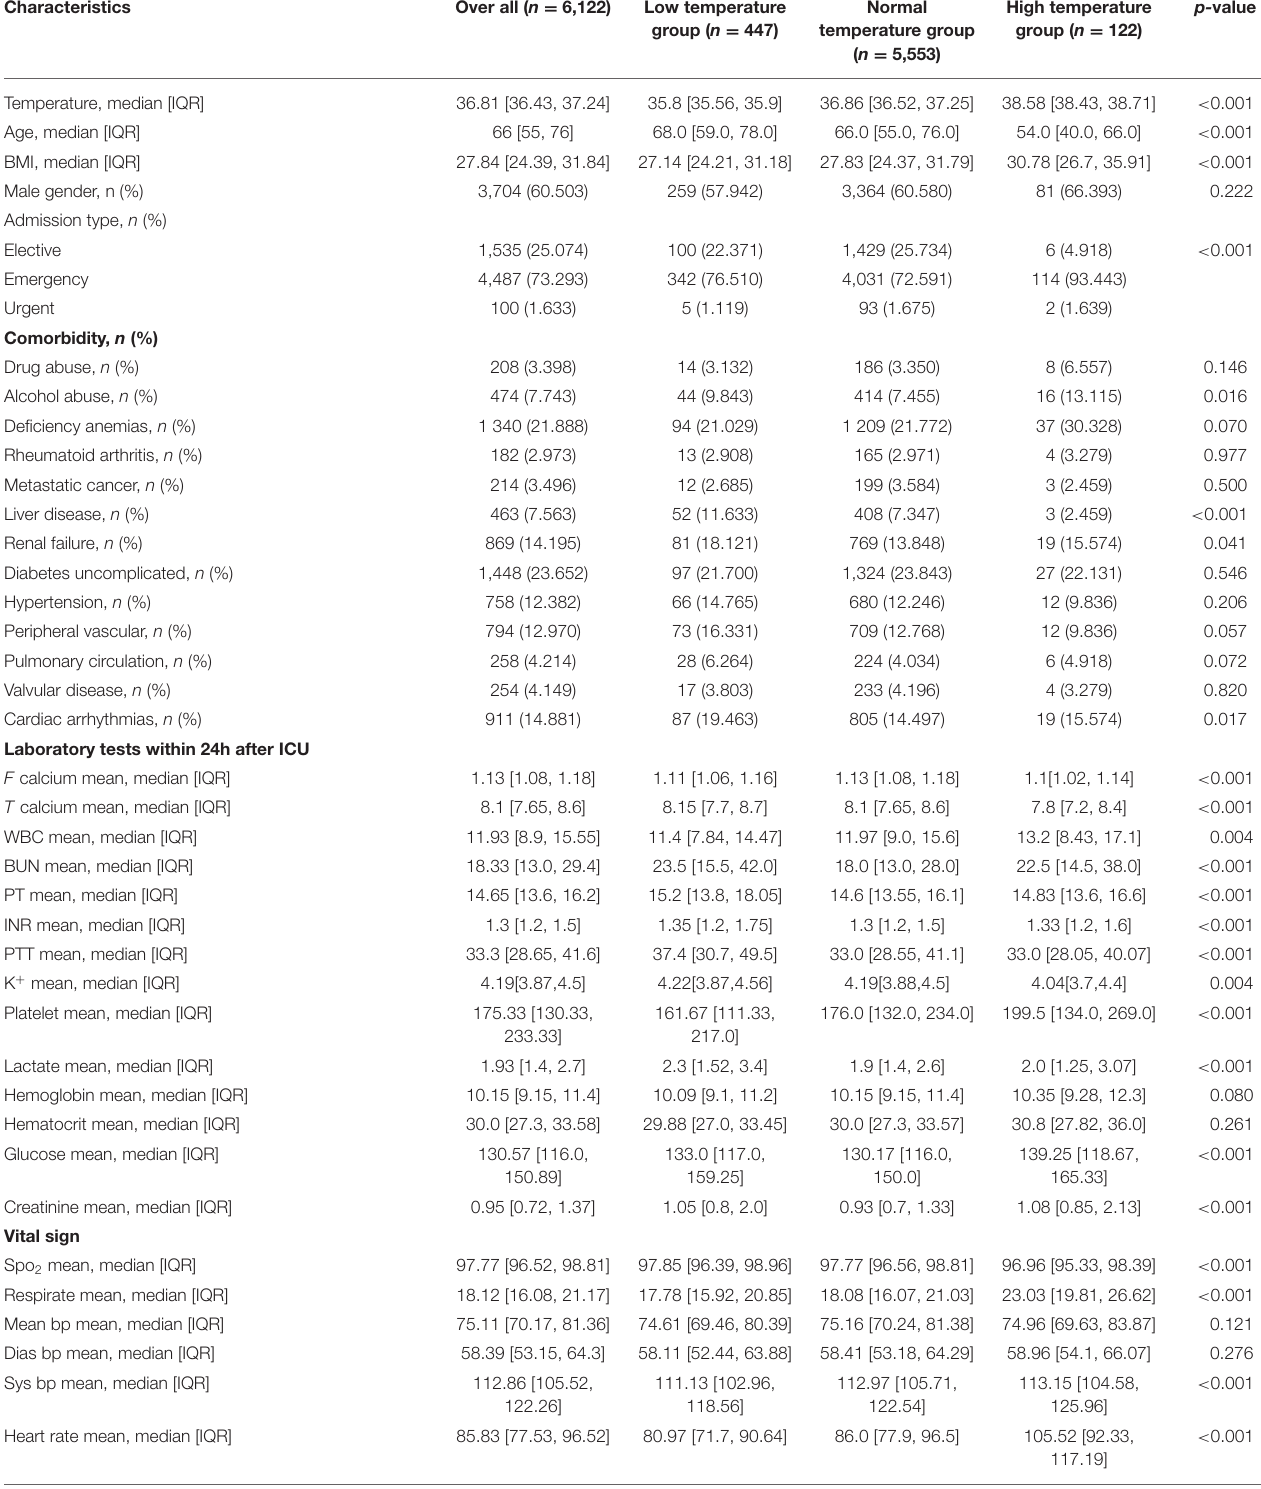
TABLE 1 | Clinical and laboratory baseline characteristics of the overall cohort.